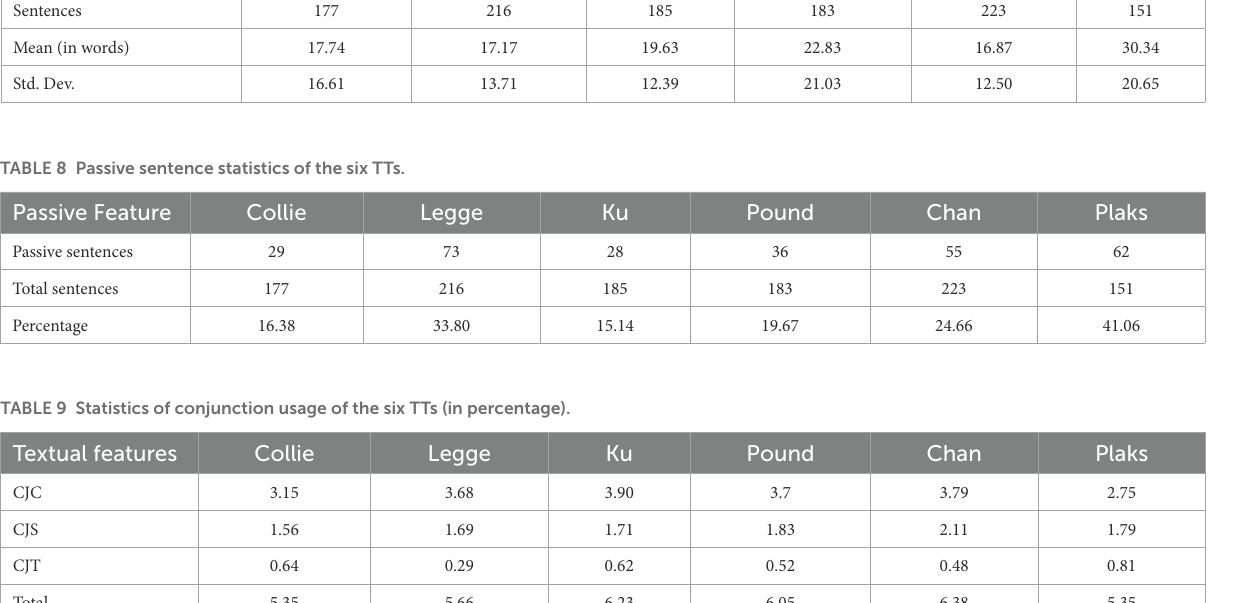
TABLE 7 Syntactic statistics of the six TTs. Syntactic Features